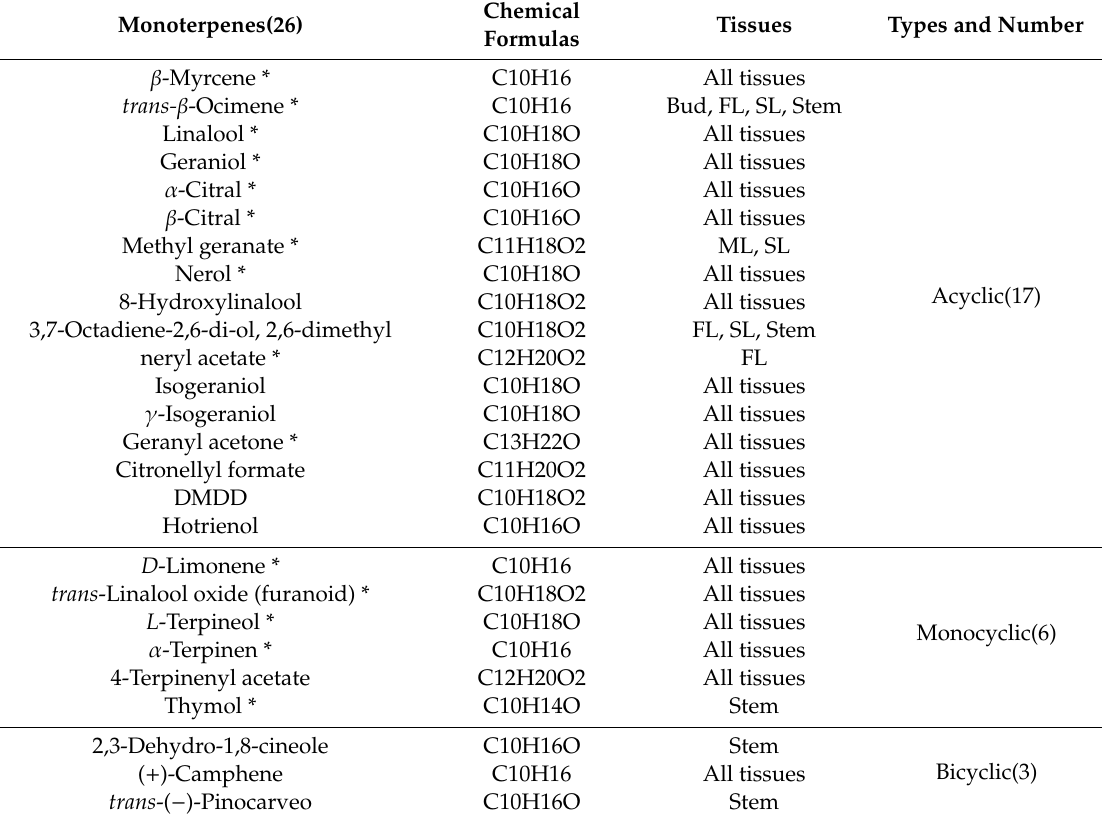
Table 1. Monoterpenoids detected in di ff erent tissues of tea plants.